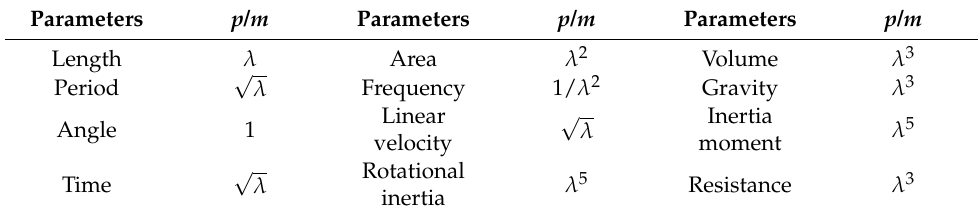
Table 1. Proportional relationship of parameters between prototype and model.